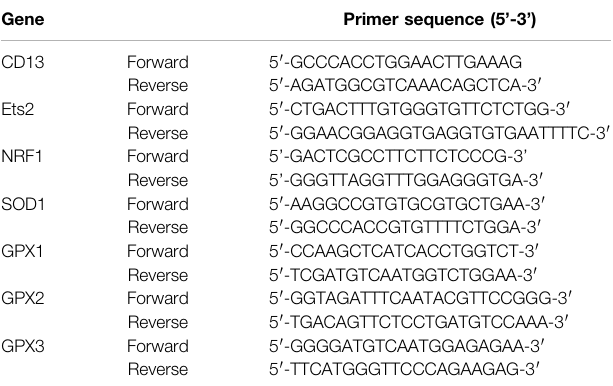
TABLE 1 | Sequences of primers used for mRNA detection by